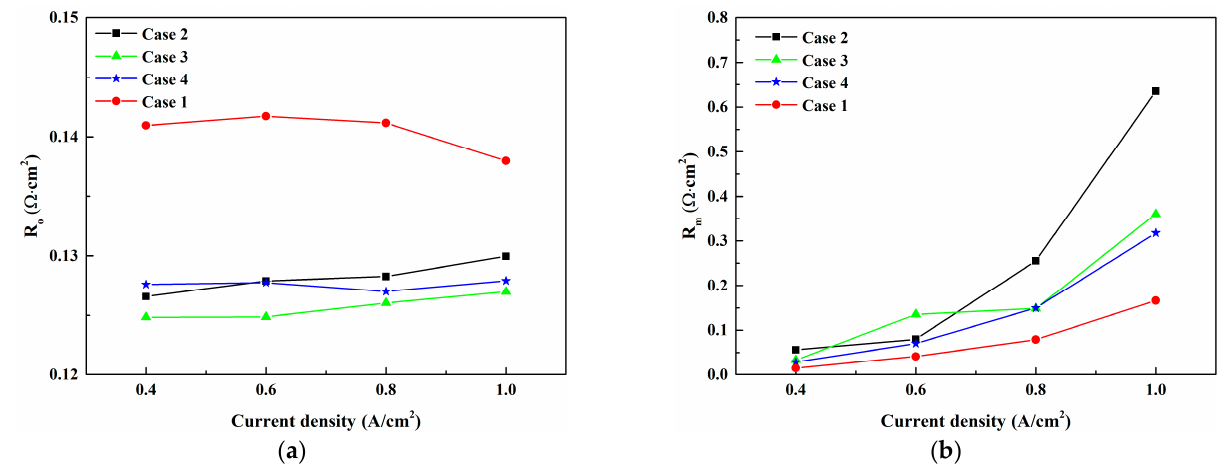
Figure 6. ( a ) Ohmic resistance and ( b ) mass transfer resistance as a function of current density in various RHa cases.